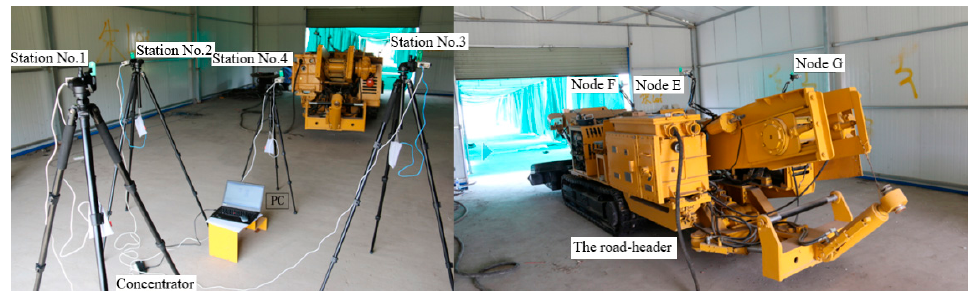
Figure 8. A prototype of the pose detection system for the roadheader.